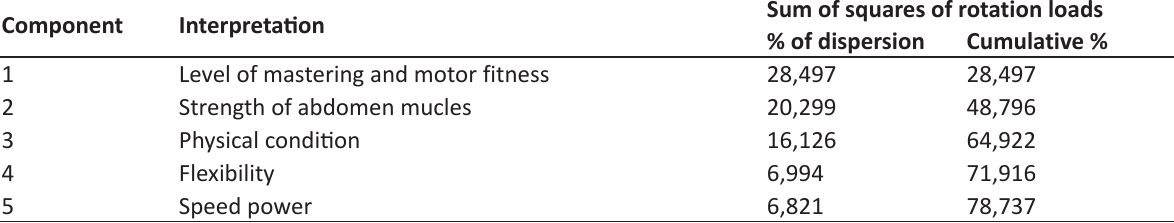
Table 7. Full explained dispersion